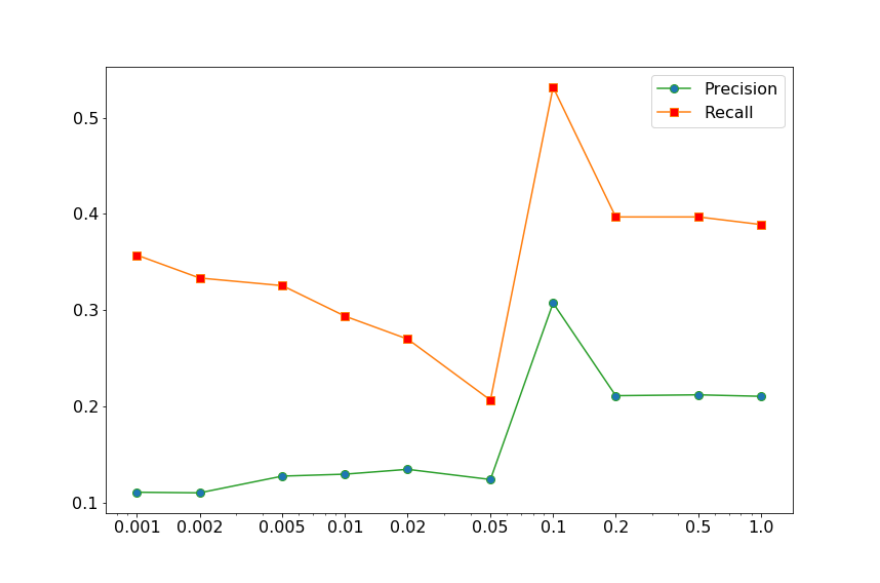
Figure 6. CVAE’s performance on the FOQA case study with different values of hyperparameter β